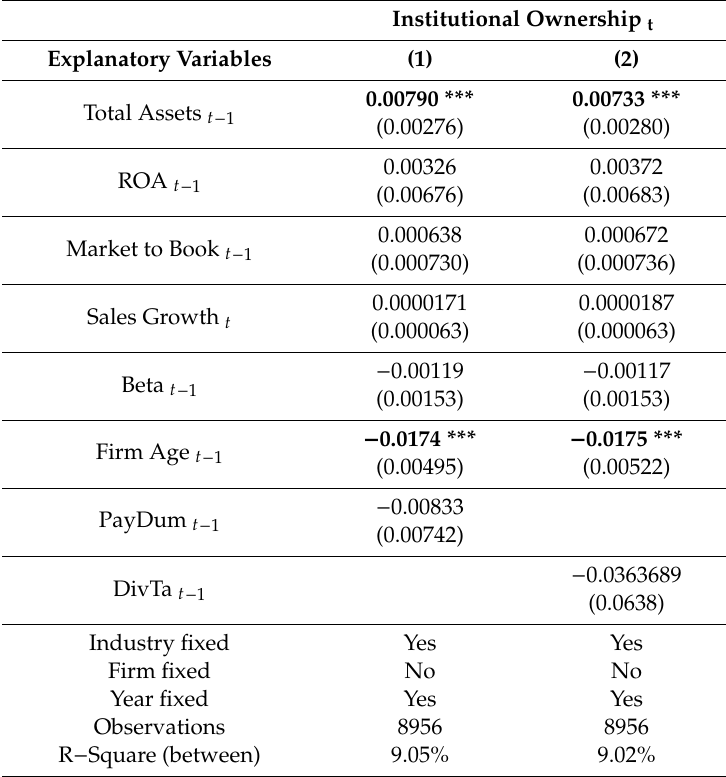
Table 4. E ff ect of Pay / No Pay Decision and Dividend Ratio on Institutional Holdings. This